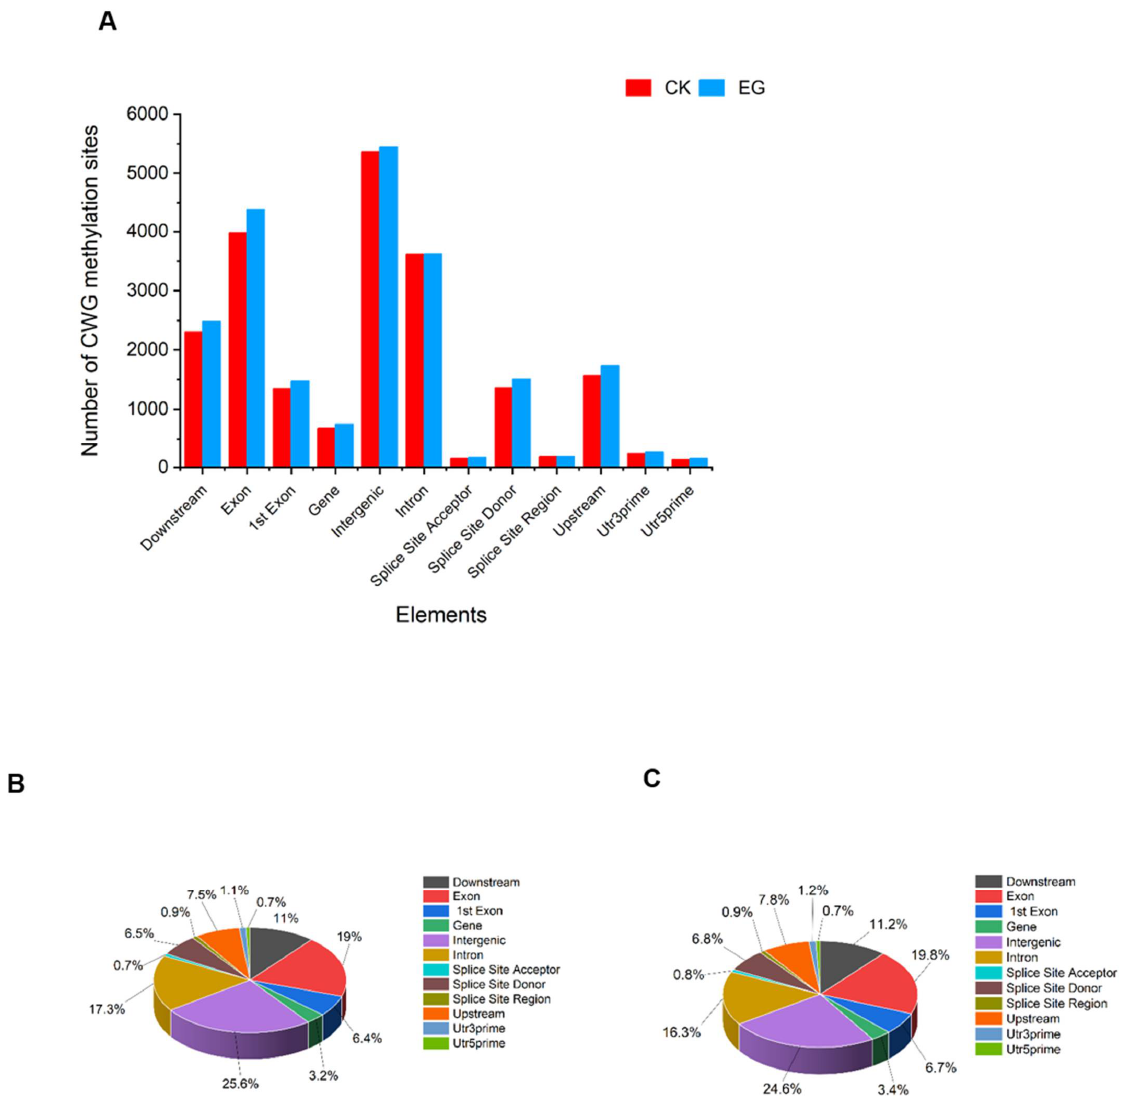
Figure 4. Distribution of methylation sites in different gene functional elements. ( A ) The distribution of mCWG in elements count. ( B ) The proportion of the mCWG (W = A or T) distribution in the CK samples. ( C ) The proportion of the mCWG distribution in the EG samples. CK is the control sample, and EG is the drought-stress sample.